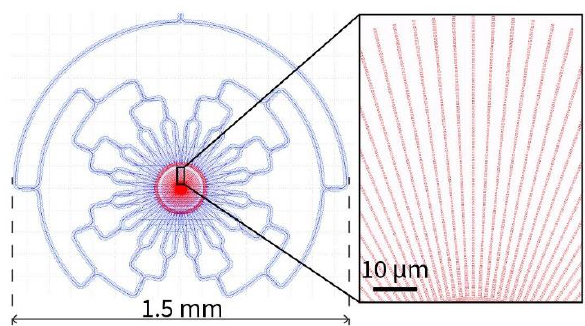
Figure 11. Schematic of the device, showing the details of apodized grating structure.